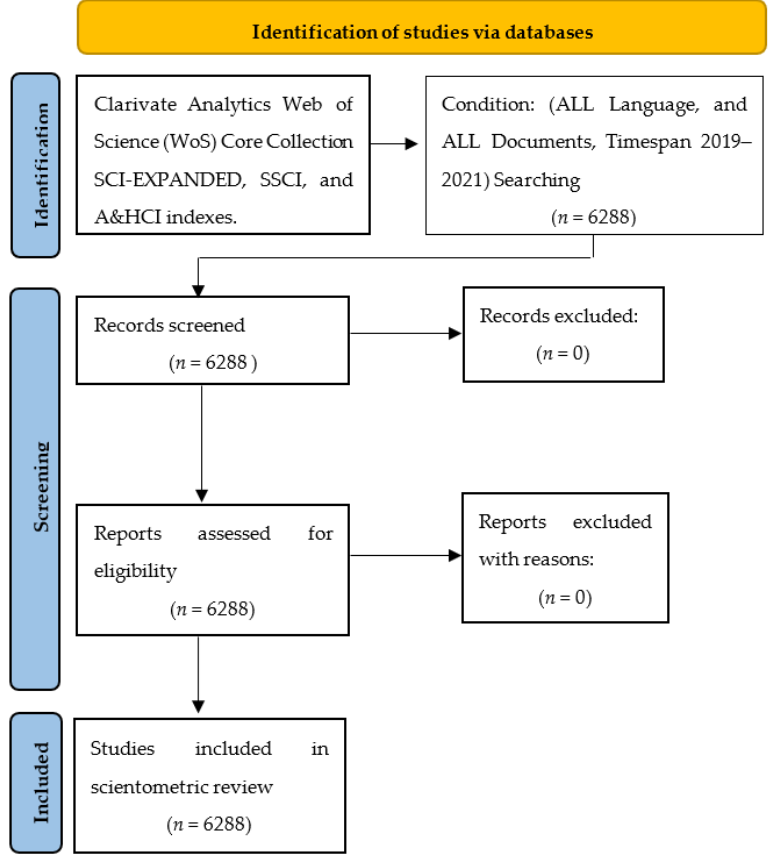
Figure 1. PRISMA flow diagram in COVID-19 vaccines.